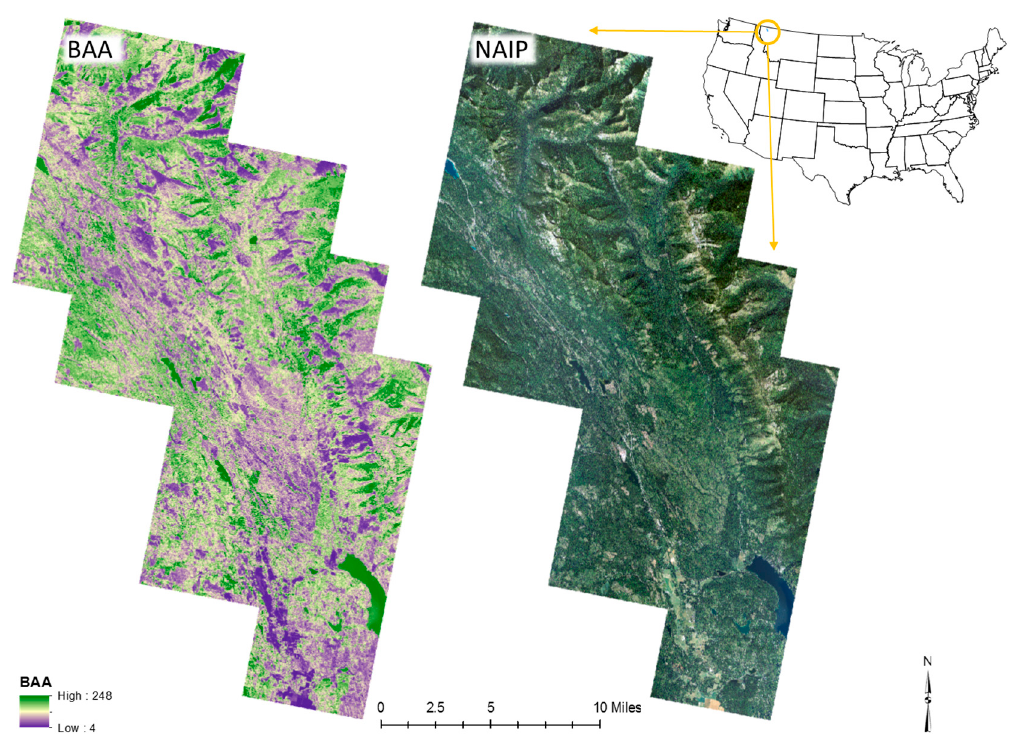
Figure 8. Example of a basal area per acre (BAA) surface created using variable radius plots, National Agricultural Imagery Program (NAIP) image texture, and a random forest algorithm within FM. As areas transition from low to high BAA, colors transition from purple to green in the BAA graphic. Note, only forested areas are represented in the modeled outputs. Non-forested areas such as water in the southeastern portion of the NAIP imagery were not used to train the random forest model and do not accurately reflect BAA in the modeled outputs.